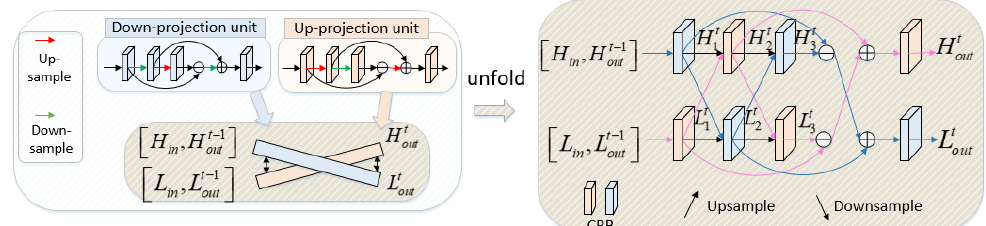
Figure 4. Dual mutual-feedback component of the t -th iteration in